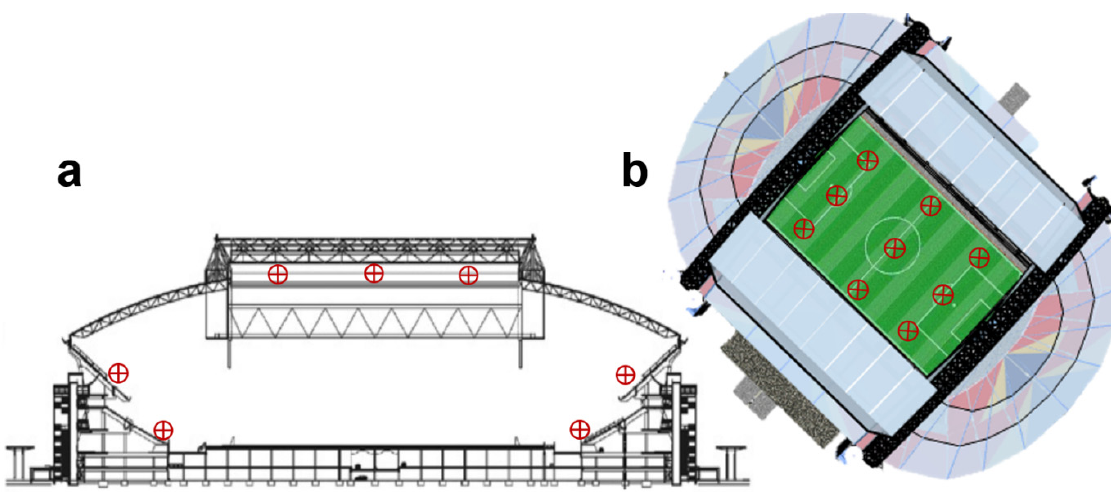
Figure 2. The semi-enclosed stadium main dimensions.